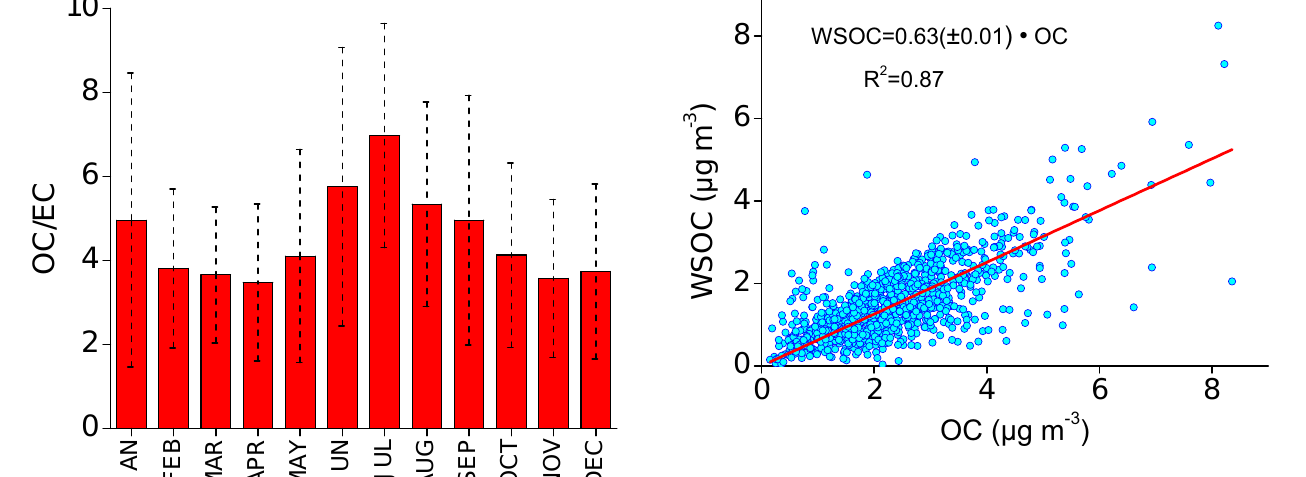
Figure 5. Scatterplot of the daily OC and WSOC concentrations for the period May 2008–April 2013.